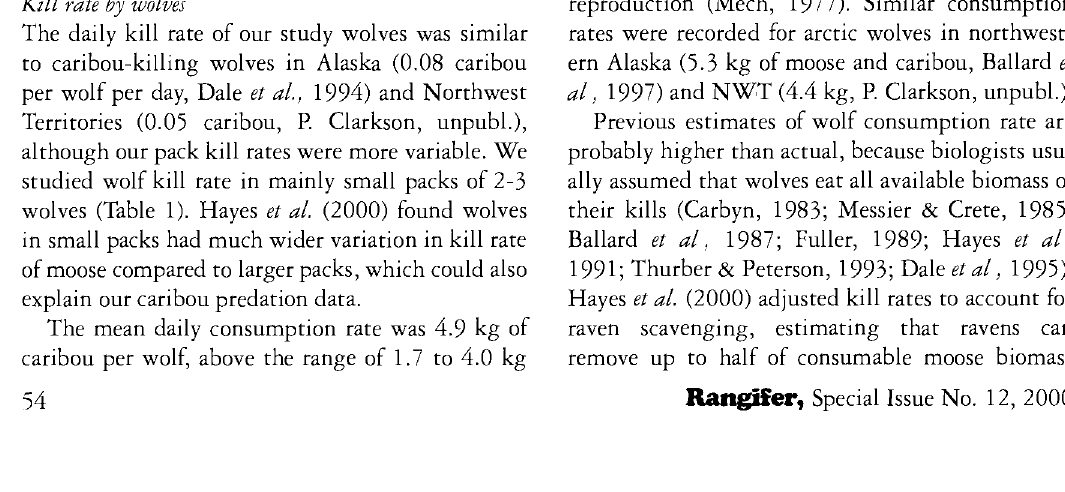
Fig. 1. Seasonal predation rate by wolves on P CH based on model. Seasonal periods correspond with num bers shown on Table